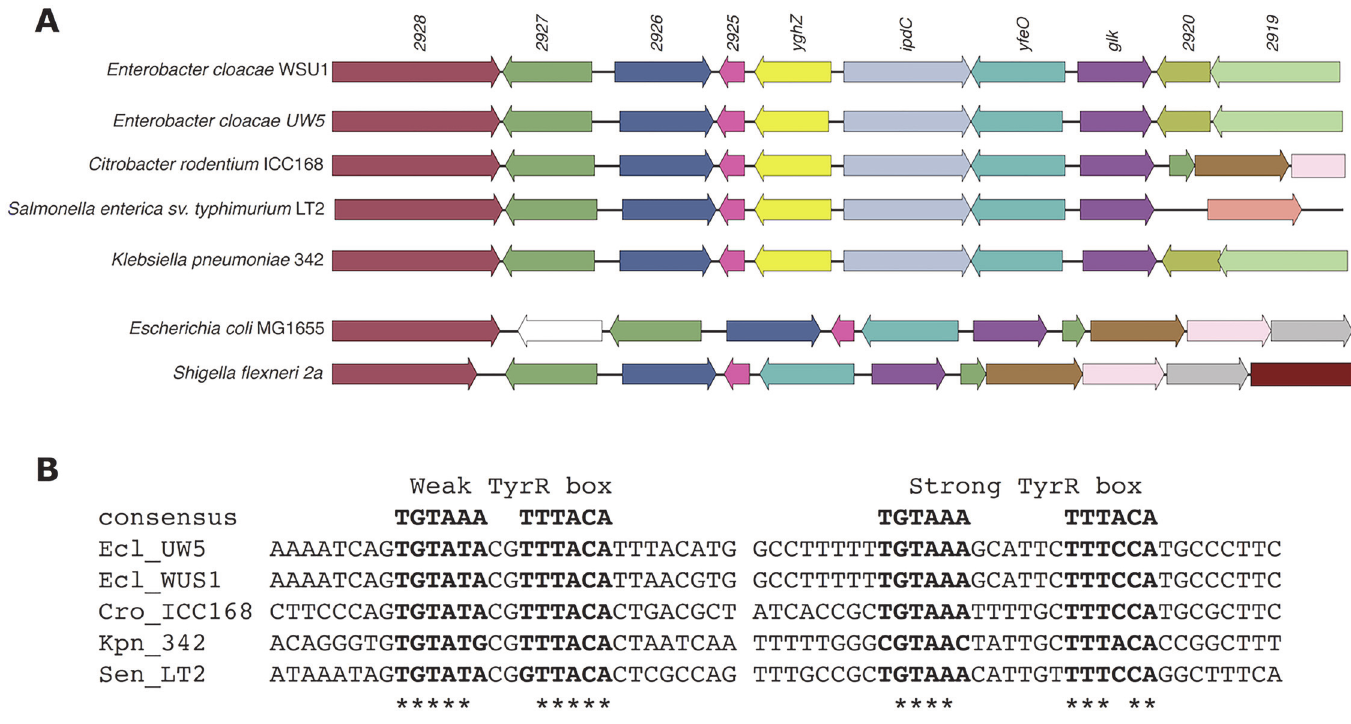
Fig 5. Conservation of the akr-ipdC genes and the two TyrR boxes across closely related bacteria. (A) Genomic context of the akr-ipdC genes in closely related Enterobacteriaceae , Homologous genes are indicated by the same colour, white indicates non-homologous genes. (B) Species with an akr- ipdC gene pair retain the weak and strong TyrR boxes. The second palindromic arm of the E . cloacae UW5 weak TyrR box is not conserved across species.